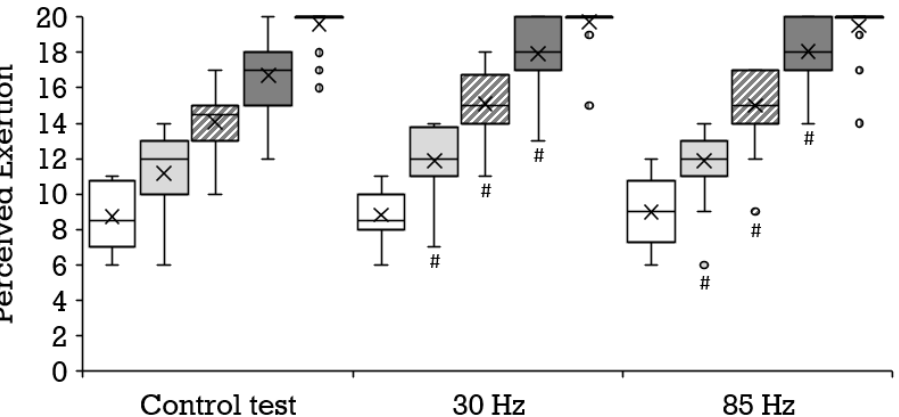
Figure 3. Distribution of the perceived exertion depicted as boxplot at the stages 8 km/h (white box, n = 22), 10 km/h (bright gray box, n = 22), 12 km/h (diagonally striped box, n = 22), and 14 km/h (dark gray box, n = 21), as well as for the maximum values (vertically striped box visible as black leveled line owed to the distribution, n = 22) during the control test, running with 30 Hz and running with 85 Hz. Each filled circle is representing a discordant value. Significances ( p < 0.05) compared to the control test are labeled with